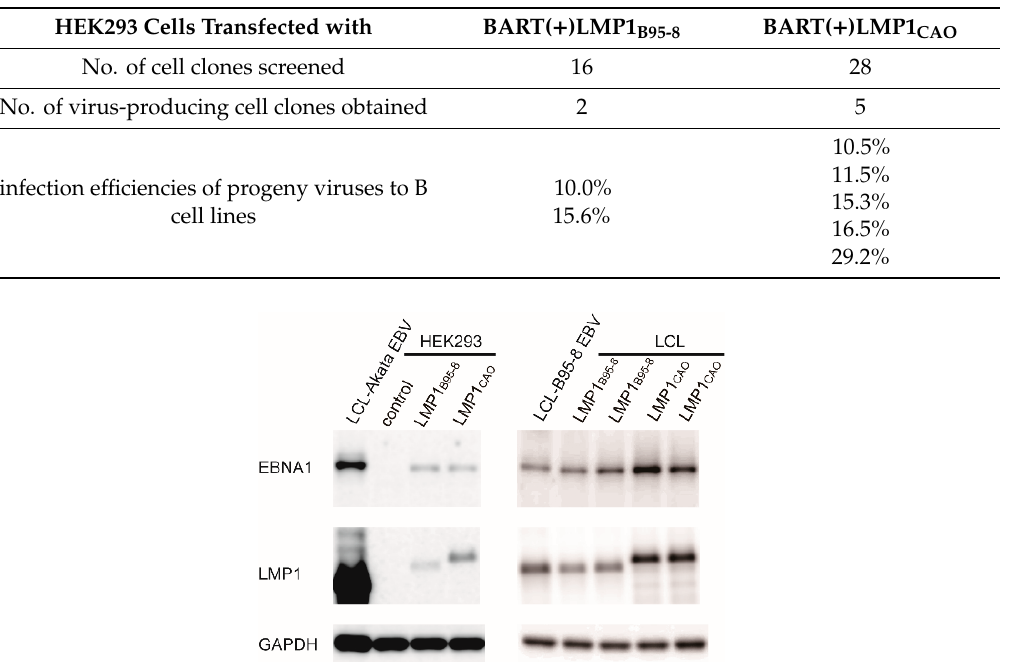
Figure 5. The effect of BART miRNA deletion on progeny virus production and NF- κ B signaling activity. ( a ) Loss of BART miRNA expression from HEK293 cells harboring BART( − )LMP1 CAO was verified by a PCR-based assay. The amounts of mature BART1-3p miRNA, whose gene is located outside of the BART deletion, are presented as 100. ( b ) Progeny viruses of BART(+)LMP1 CAO or BART( − )LMP1 CAO were used to infect EBV-negative Akata cells. The percentage of GFP-positive cells was measured by fluorescence activated cell sorting analysis. ( c ) LMP1 expression levels in stably transfected HEK293 cells harboring EBV-BAC clones as indicated (lanes 2 through 5). Lane 0; LCL established by B95-8 strain EBV. Lane 1; control HEK293 cell. ( d ) The NF- κ B reporter plasmid was used to examine NF- κ B signaling activities in HEK293 cells harboring various EBV-BAC clones. Lane numbers correspond to those in ( c ).